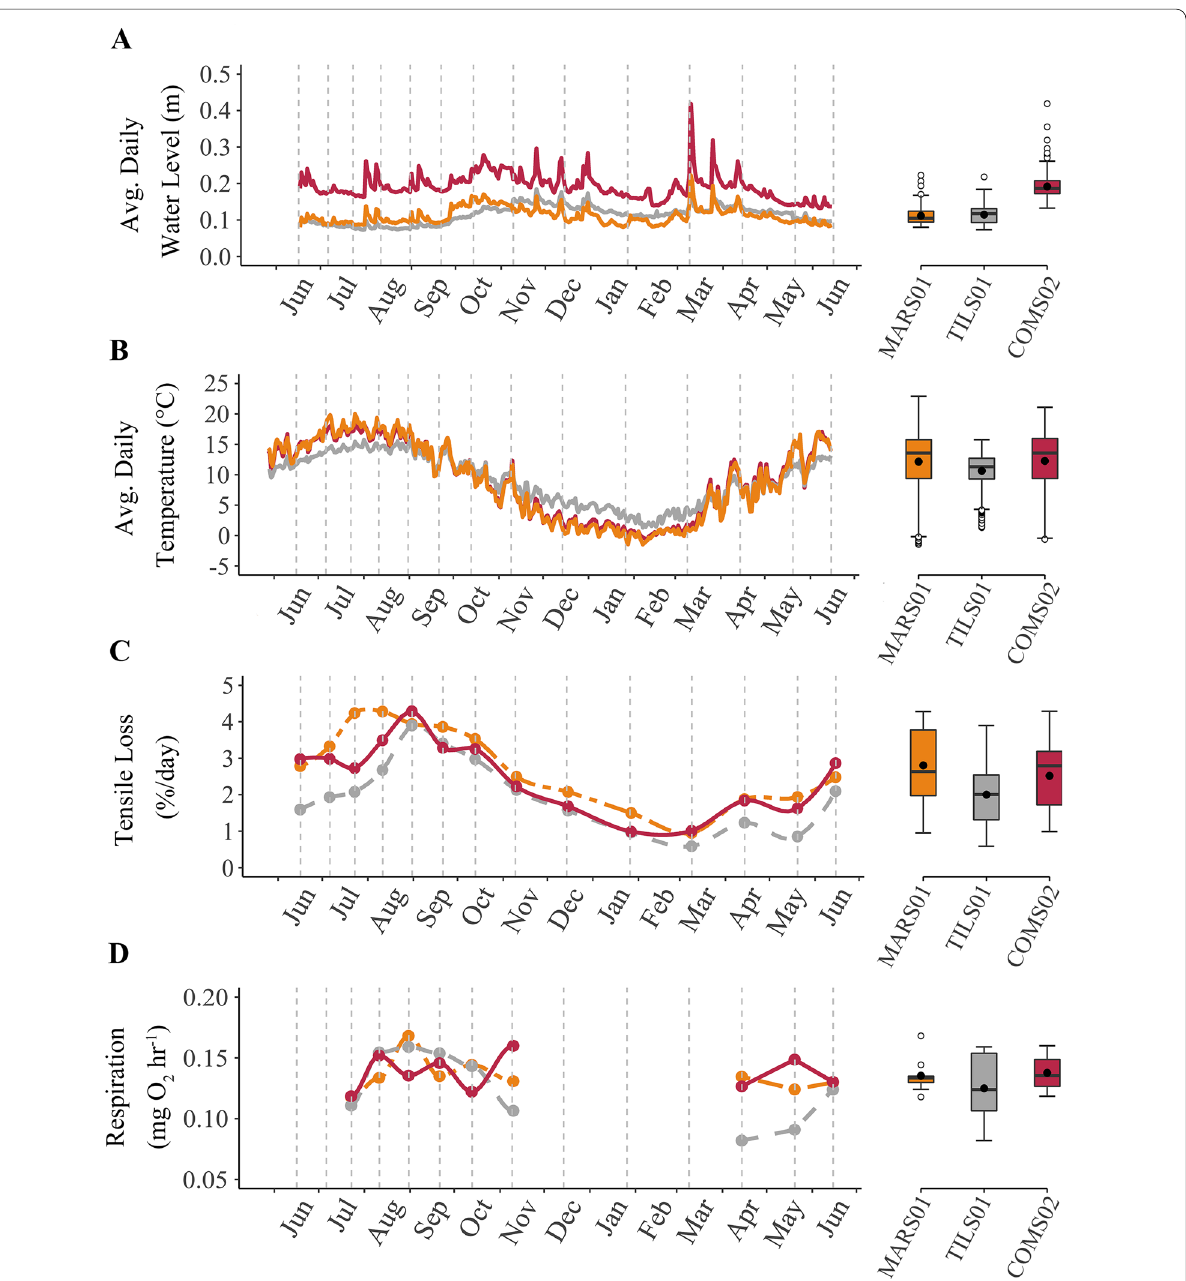
Fig. 3 Time series and boxplots of average daily water level ( A ), average daily stream temperature ( B ), % tensile loss per day ( C ), and benthic respiration ( D ) segments sourced by the marsh (two dash, orange) and tile drain (dash, grey), as well as the downstream combined segment (solid, magenta) of a headwater stream branch in southwestern Ontario, Canada sampled from June 2020 through June 2021. Grey, vertical, dashed lines denote sampling events. Boxplots indicate 25th, 50th, and 75th percentiles (box), mean (closed